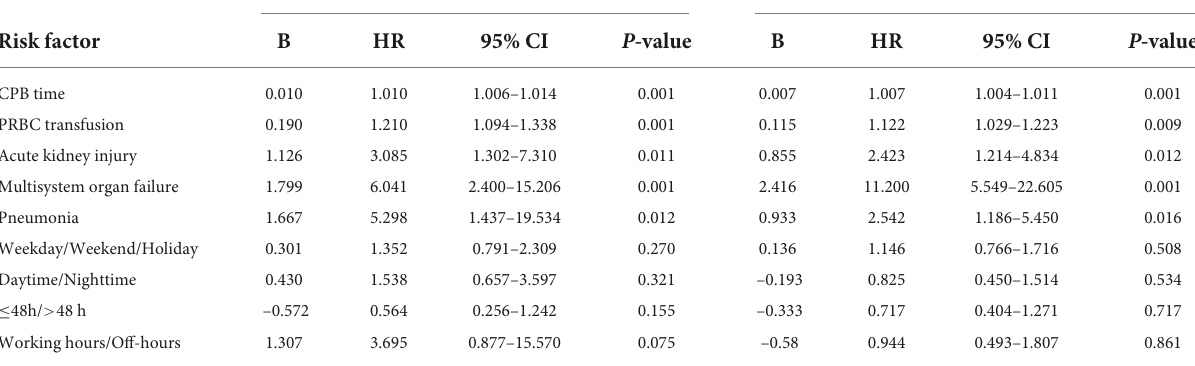
TABLE 7 Risk analysis of 7-day death and in-hospital death. Deaths within 7 days Deaths within hospital